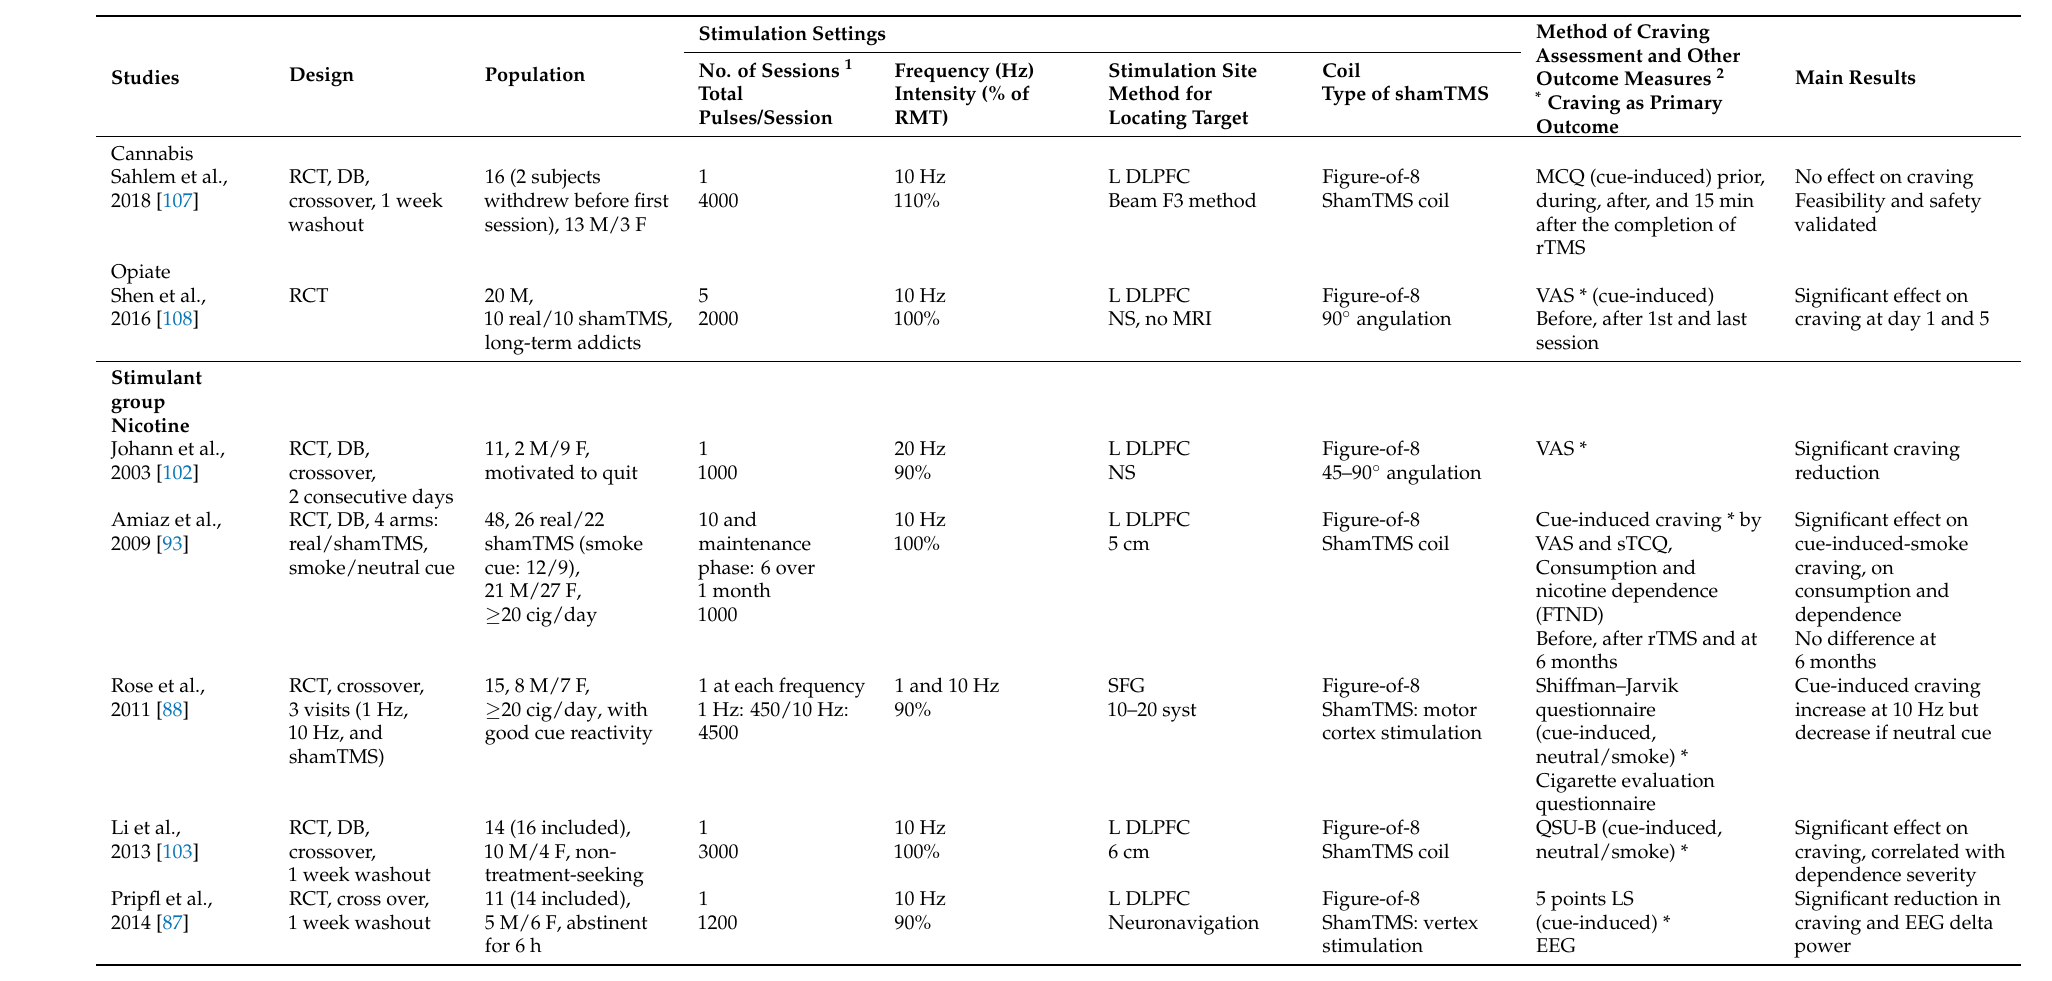
Figure-of-8 ShamTMS coil Figure-of-8 ShamTMS: vertex